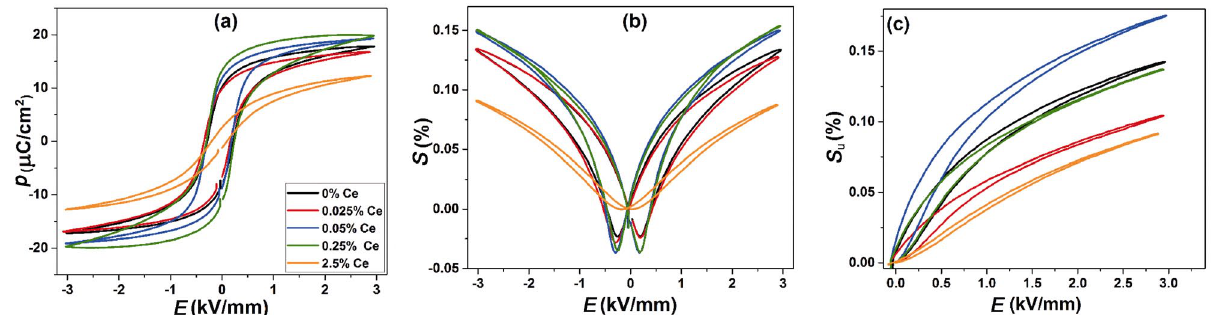
Fig. 6 (a) Bipolar polarization, (b) bipolar strain, and (c) unipolar strain loops for Ce-doped samples.